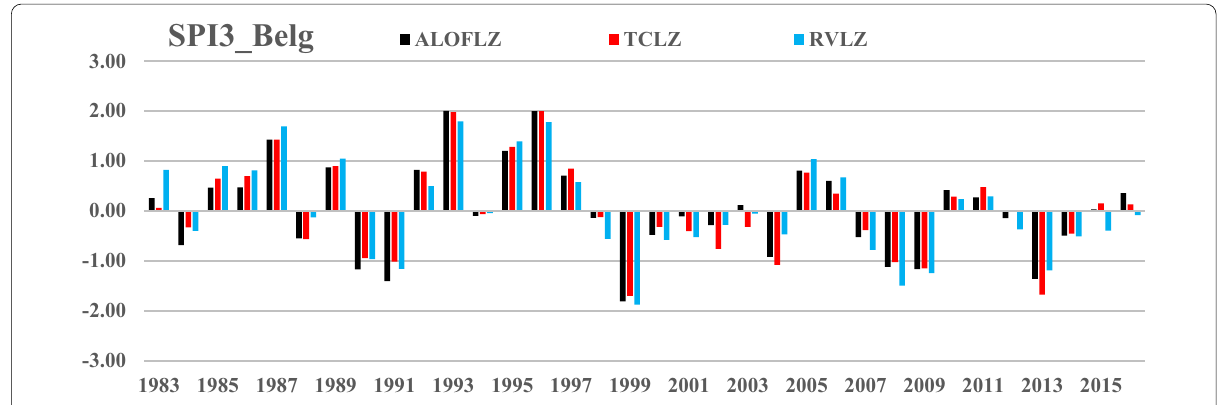
Fig. 2 Temporal drought trends in Belg seasons from